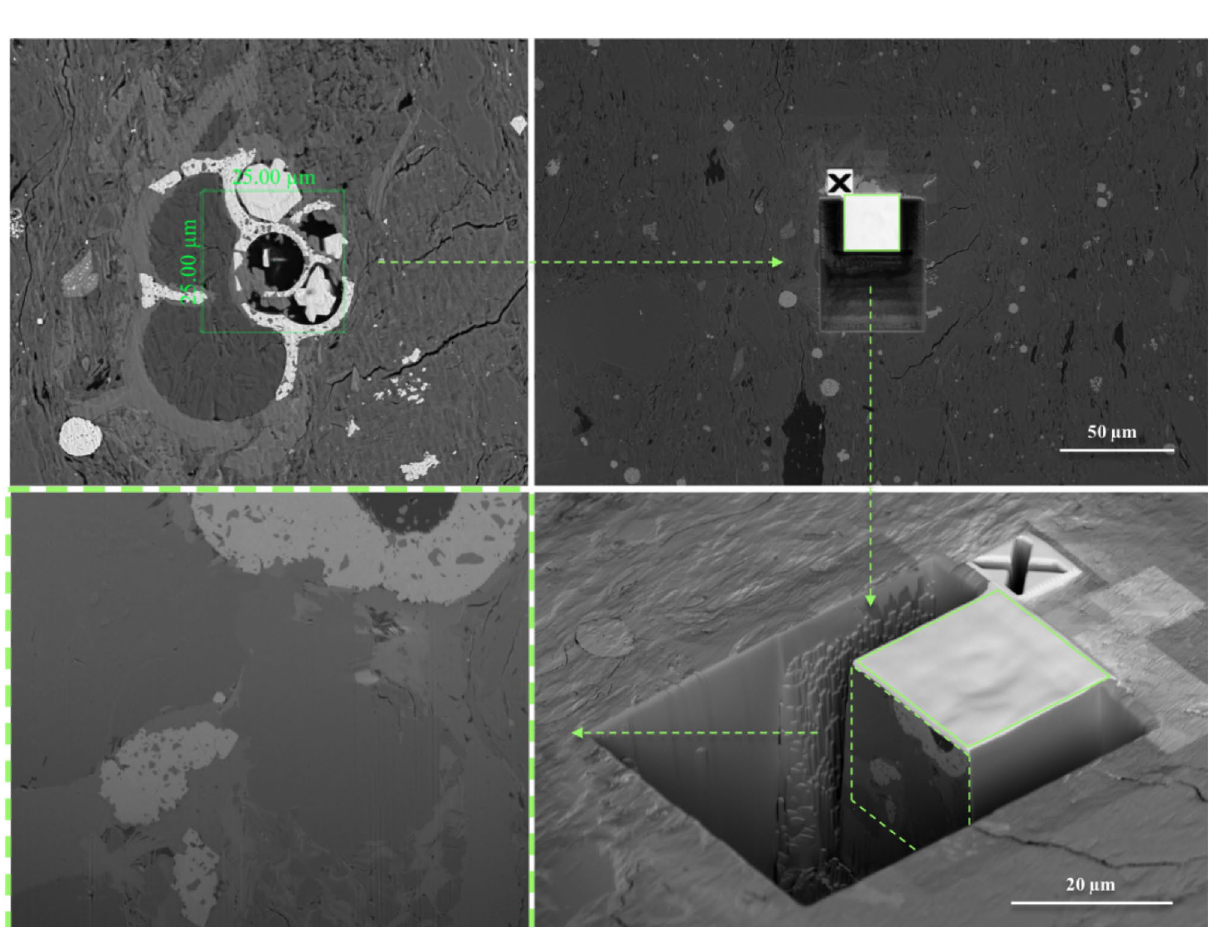
Figure 10. Schematic diagram illustrating an example of dual-beam focused ion beam—scanning electron microscopy (FIB-SEM) nano-tomography (serial-sectioning) experimental